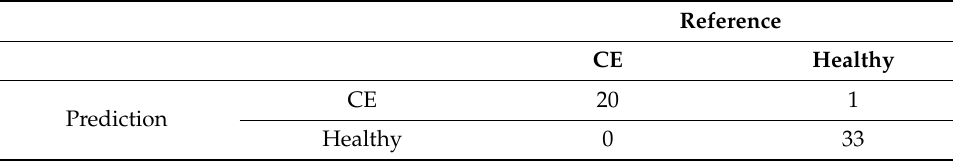
Table 1. Confusion matrix obtained by running the random forest (RF) classification model estimated at species level on a test set of 54 subjects.